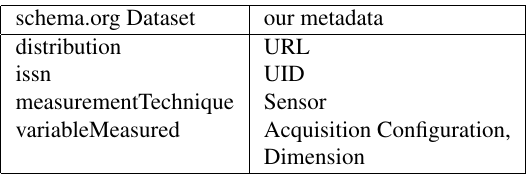
Table 4. Possible attribute values for sensor and acquisition configuration